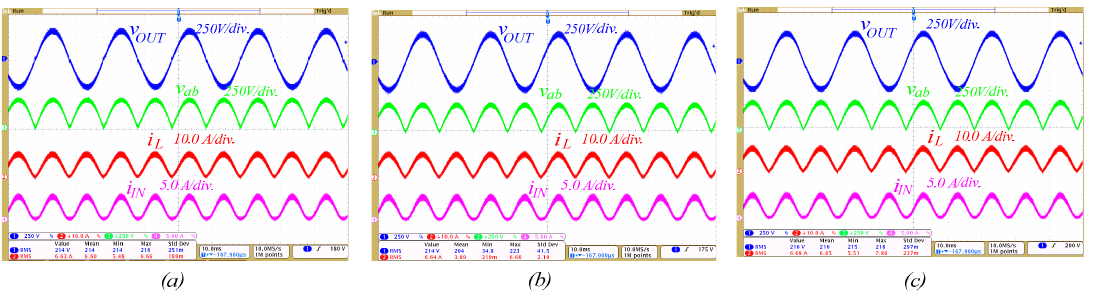
Figure 11. Experimental results for V in = 350 V, P in = 850 W in the inverter mode without synchronous switching and separate control ( a ), without synchronous switching and with separate control ( b ), with synchronous switching and with separate control ( c ).